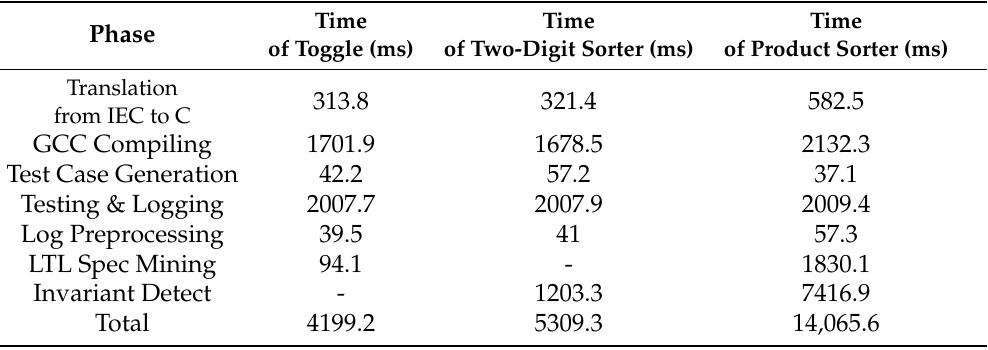
Table 2. Time of each